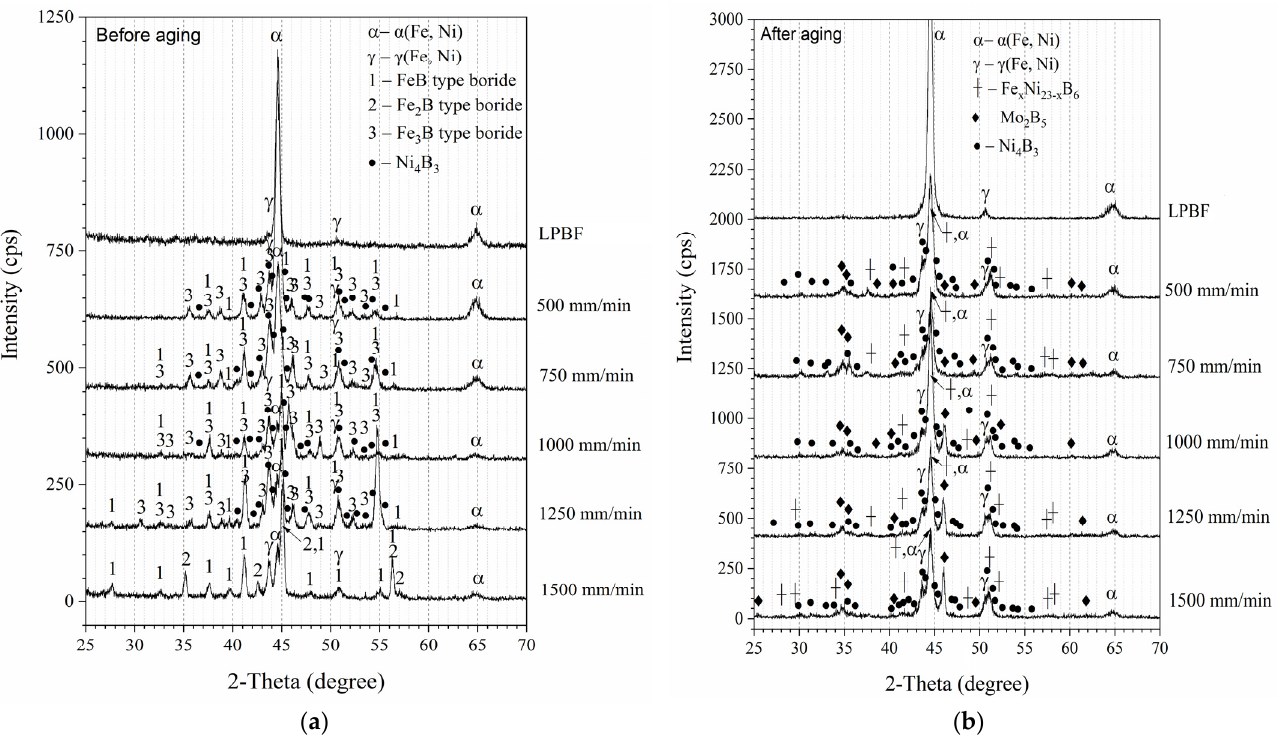
Figure 7. XRD patterns of as-manufactured LPBF specimen (LPBF) and specimens boronized at dif- different laser operating speeds (from 500 mm/min to 1500 mm/min) before ( a ) and after ( b )